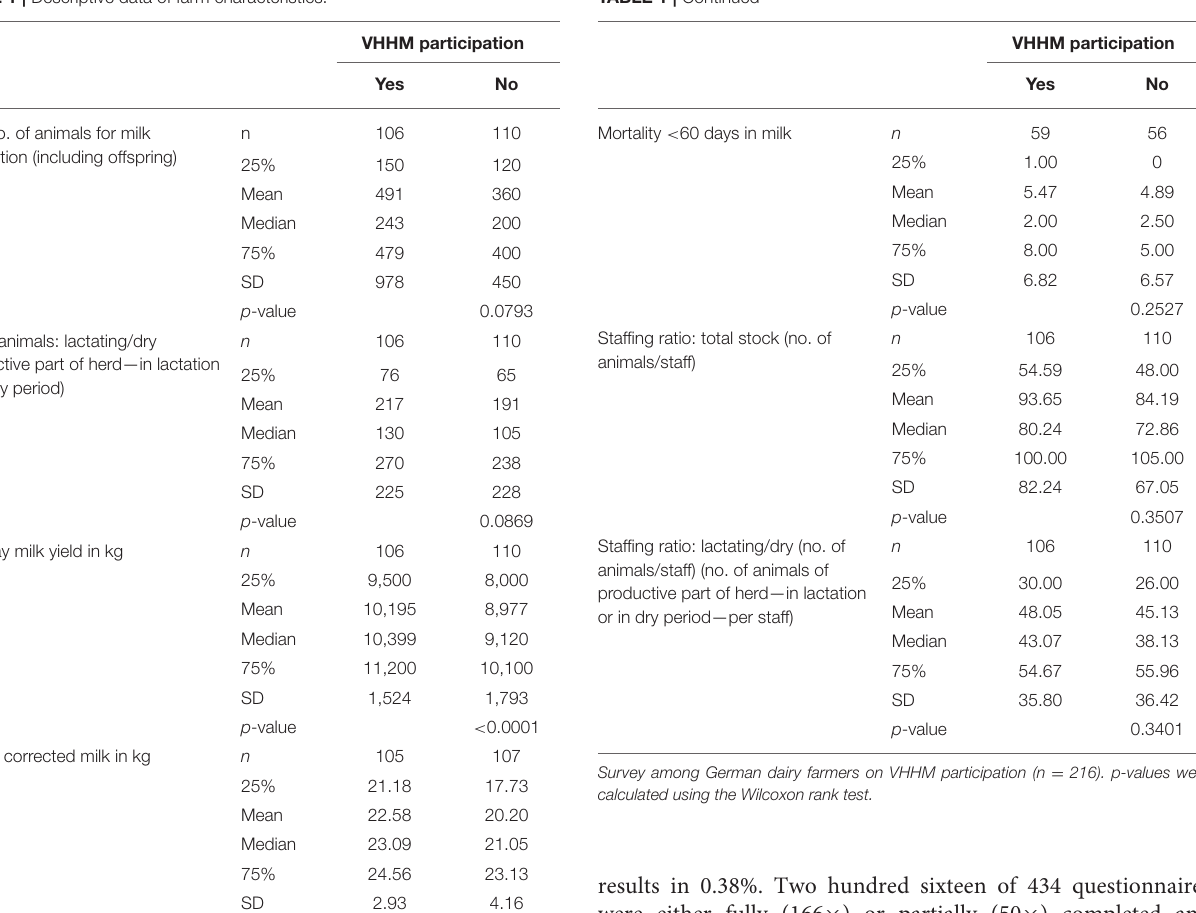
TABLE 1 | Descriptive data of farm characteristics.